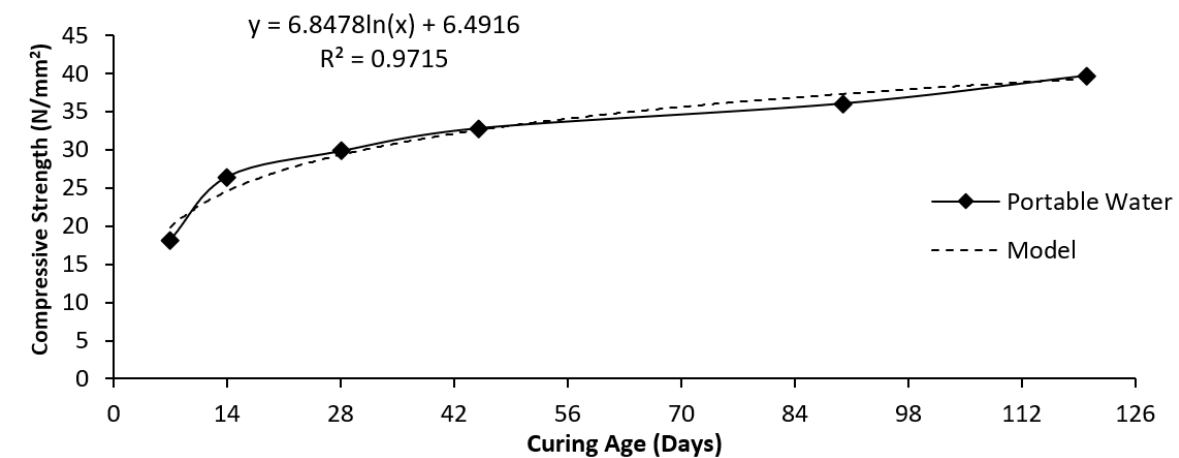
Figure 6. Compressive strength of concrete cured in potable water